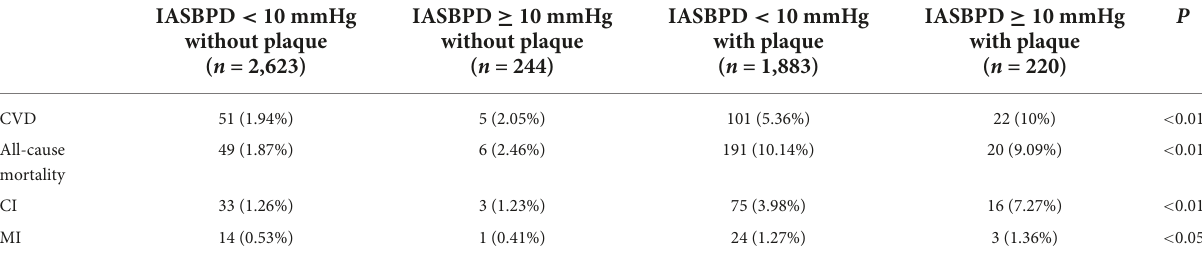
TABLE 2 Incidence of cardiovascular disease (CVD) events and all-cause mortality among the